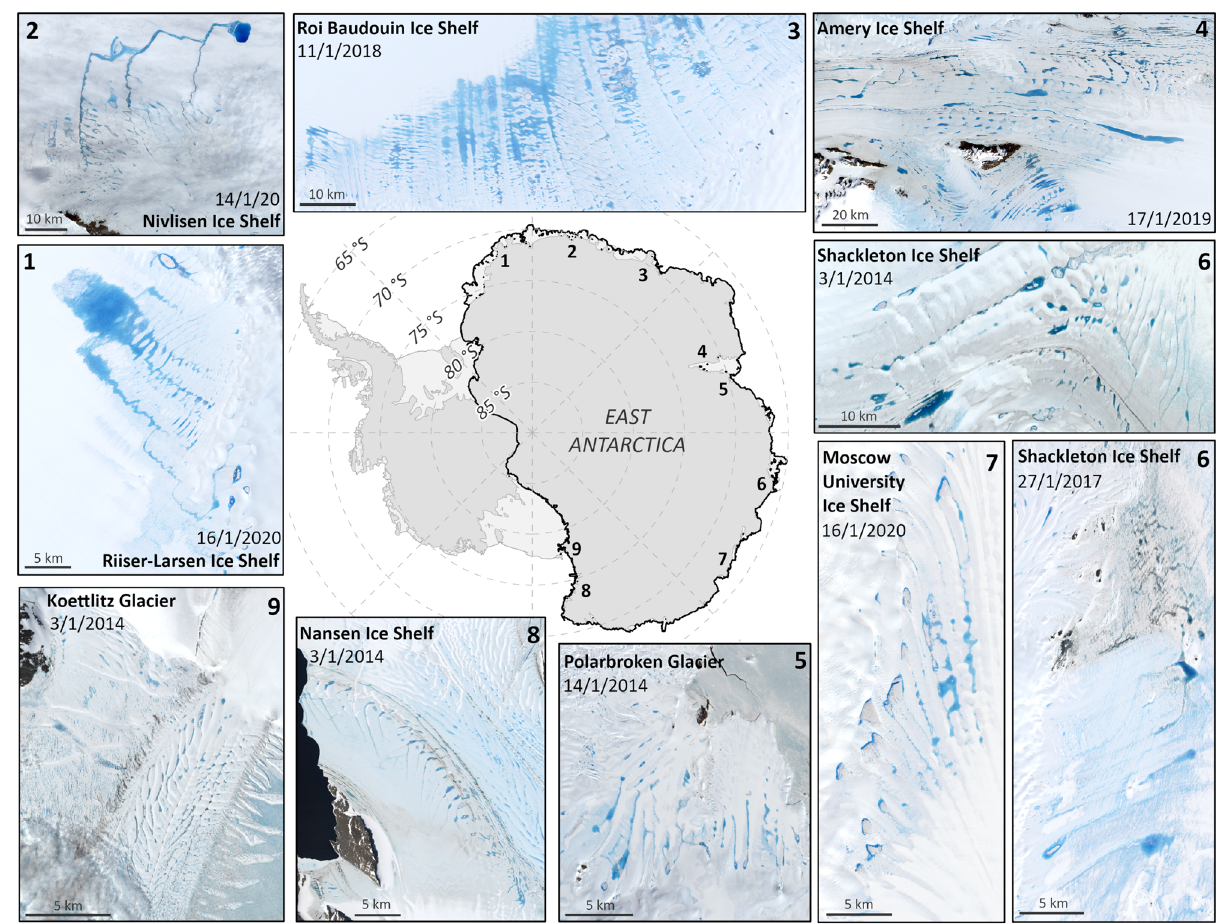
Fig. 1 Examples of supraglacial lakes on selected East Antarctic ice shelves and outlet glaciers. (1) Riiser-Larsen Ice Shelf, (2) Nivlisen Ice Shelf, (3) Roi Baudouin Ice Shelf, (4) Amery Ice Shelf, (5) Polarbroken Glacier/Publications Ice Shelf, (6) Shackleton Ice Shelf, (7) Moscow University Ice Shelf, (8) Nansen Ice Shelf and (9) Koettlitz Glacier. This fi gure highlights the distribution of SGLs across these major ice shelves but note that lakes occur with less frequency in other regions, for example along the Ingrid Christensen Coast (between Polarbroken Glacier and Shackleton Ice Shelf) and on Voyeykov Ice Shelf (adjacent to Moscow University Ice Shelf). Details of Landsat 8 images are in Supplementary Table 5. Grounding line from ref. 77 and coastline from ref. 78